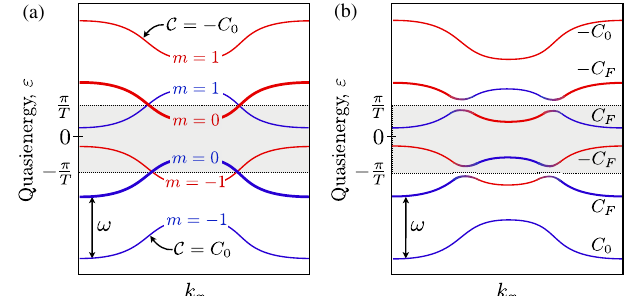
FIG. 5. Floquet bands for a two-band model in the truncated repeated zone scheme. Representative one-dimensional cuts through the two-dimensional crystal-momentum Brillouin zone are each are shown. (a) For (cid:2) ¼ 0 , the unperturbed bands of H 0 copied and shifted up and down one time; m ¼ (cid:1) 1 ; 0 ; 1 . The . The crossings between bands have Chern numbers C ¼ (cid:4) C 0 bands with m values differing by 1 correspond to points in the Brillouin zone where the driving field resonantly couples the two bands. (b) For (cid:2) (cid:1) 0 , a generic driving field opens avoided crossings at the resonance points. After coupling, the Chern . In the numbers of the crossed bands are changed to C ¼ (cid:4) C F truncated scheme, the appearance of Floquet edge states at a particular quasienergy in the first quasienergy Brillouin zone FIG. 4. Floquet Hamiltonian and level diagram in the repeated (gray regions) can be predicted by adding up the Chern numbers zone scheme. (a) When the driving (cid:2) ð t Þ consists of a single of all bands below harmonic with angular frequency ! , the Floquet Hamiltonian H ð k Þ [see Eq. (18)] assumes a block-tridiagonal form. Each block is an N (cid:5) N matrix, where N is the number of bands . The off-diagonal blocks in the unperturbed Hamiltonian H 0 labeled by (cid:2) and (cid:2) y describe transitions accompanied by the absorption and emission of a driving field photon, respectively. (b) Schematic Floquet level diagram. The N -level spectrum of ð k Þ , which spans an energy range (cid:3) , is copied and rigidly H 0 shifted by m! for each value of m . The harmonic driving (cid:2) induces transitions between neighboring copies with m values differing by 1. Analogous to Wannier-Stark states, the Floquet eigenstates in the first quasienergy Brillouin zone (gray shaded region) are localized in m , with amplitudes highly suppressed for j m j (cid:8) (cid:3) =! .